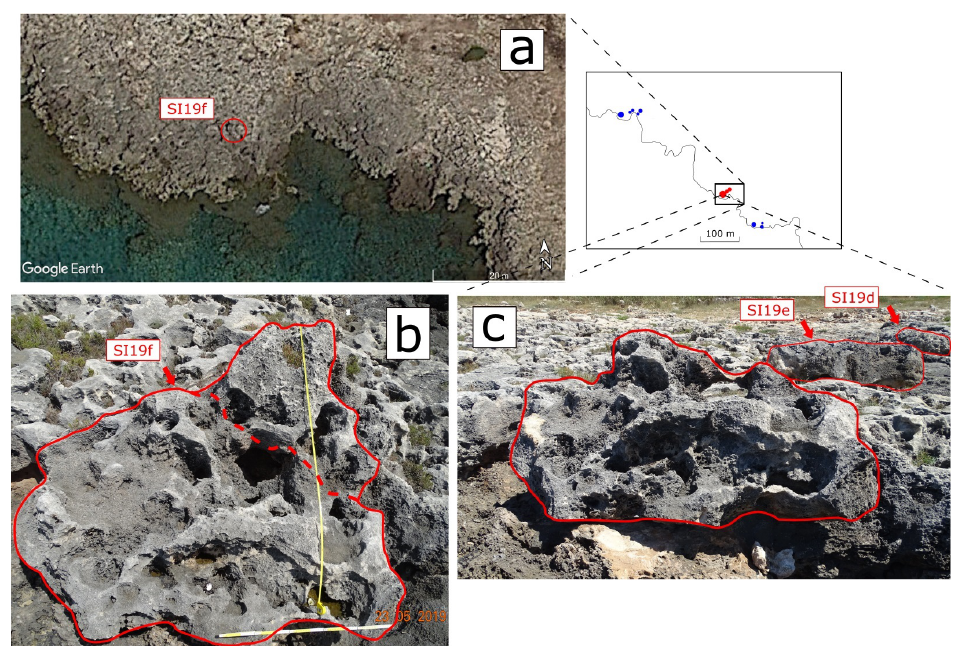
Figure A4. Comparison between pre- and post-storm event states: ( a ) 2015 Google Earth satellite image with the location of Boulder f; ( b ) pre-storm image of the boulder with the new fracture; ( c ) post-storm image of f (note the change of shape) with Boulders d and e in the background. The fresh unweathered rock surface under the boulder is part of the socket.